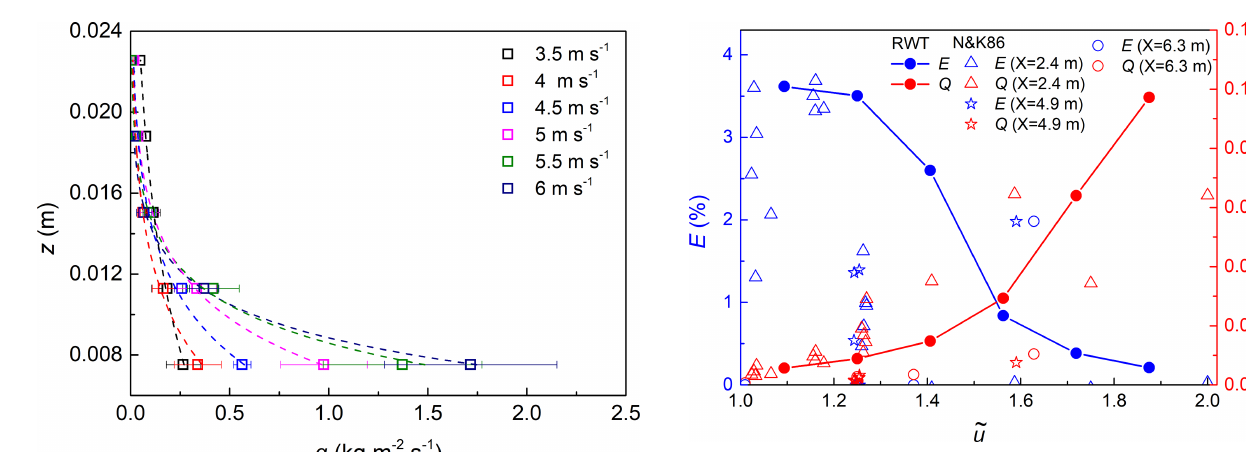
Figure 4. Mass flux variation with height under different wind con- ditions (3.5–6ms − 1 ). The dashed lines are exponentially fitted.